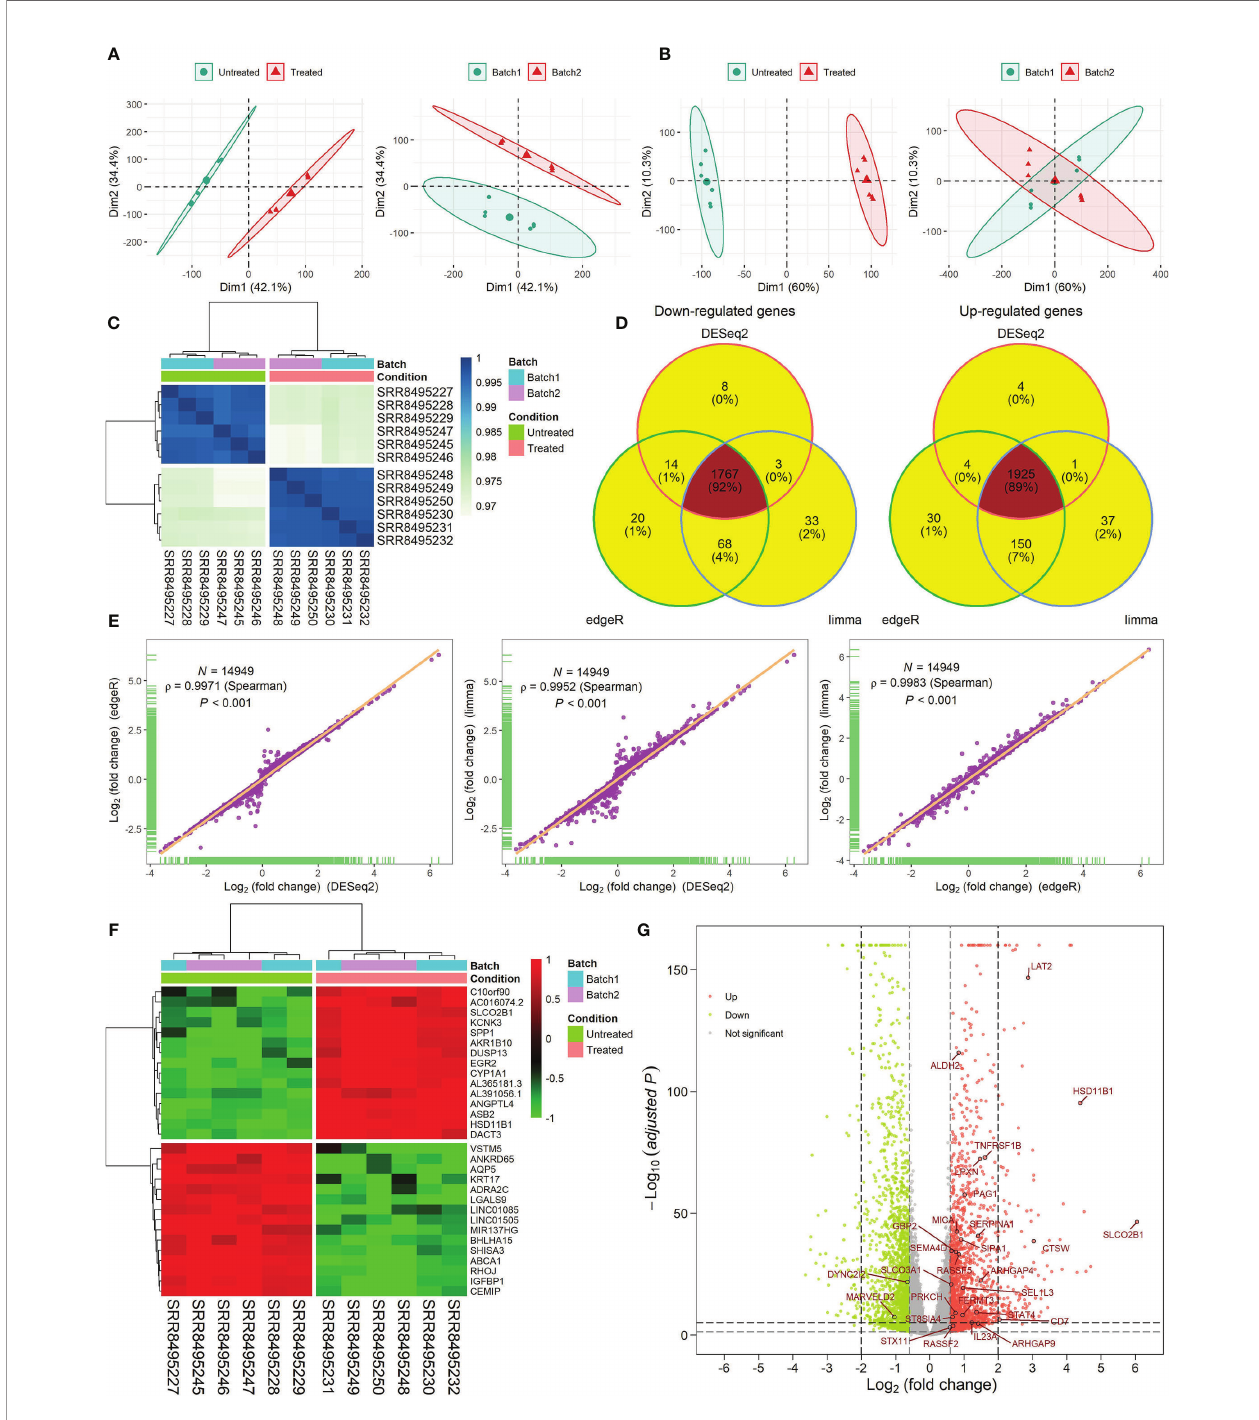
FIGURE 2 | RNA-seq data analysis for six CKI-perturbed and six control cell line samples. (A, B) PCA for the transcriptome pro fi les before removing batch effects (A) and after removing batch effects (B) . (C) Hierarchical clustering of 12 samples using Spearman distance. (D) Venn diagram of DEGs calculated by three methods. (E) High correlation of log 2 FC calculated by three methods. The correlation coef fi cient ( r ) is generated by Spearman ’ s correlation. (F) Hierarchical clustering of consistent DEGs detected by three methods. Top 15 up- and down-regulated DEGs are shown in the heatmap. (G) Volcano plot of DEGs. Log 2 FC and P values calculated by DESeq2 were used. The red dot represents up-regulated genes (adjusted P < 0.05 and log 2 FC > log 2 1.5) and the green dot represents down- regulated genes (adjusted P < 0.05 and log 2 FC < -log 2 1.5). A total of 28 TME- and prognosis-relevant genes perturbed by CKI were